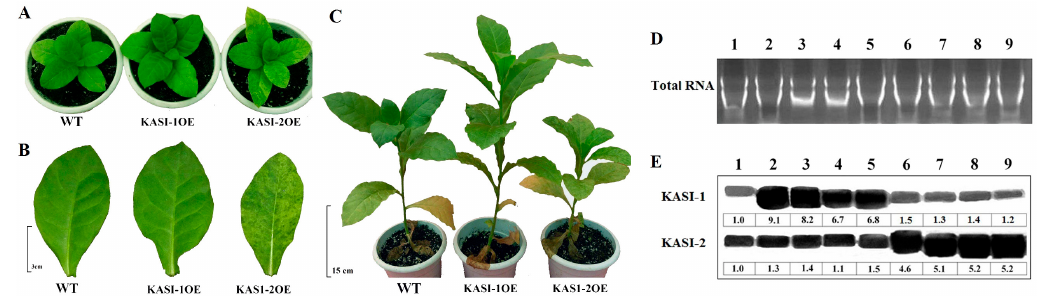
Figure 4. Phenotypic observation of NtKASI over-expression lines compared to WT plants: ( A ) phenotype at early-vegetative growth stage in WT, KASI-1OE and KASI-2OE line; ( B ) the leaf phenotype at early-vegetative growth stage (bar = 3 cm); ( C ) comparison of the growth at mid-vegetative growth stage (about four-month-old plants, bar = 15 cm); ( D ) total RNA were loaded on 1.2% agarose gels and stained with EtBr in buffer; and ( E ) Northern blot analysis for the expression of NtKASI-1 and NtKASI-2 gene in WT (Lane 1), KASI-1OE lines (Lane 2–5) and KASI-2OE lines (Lane 6–9).